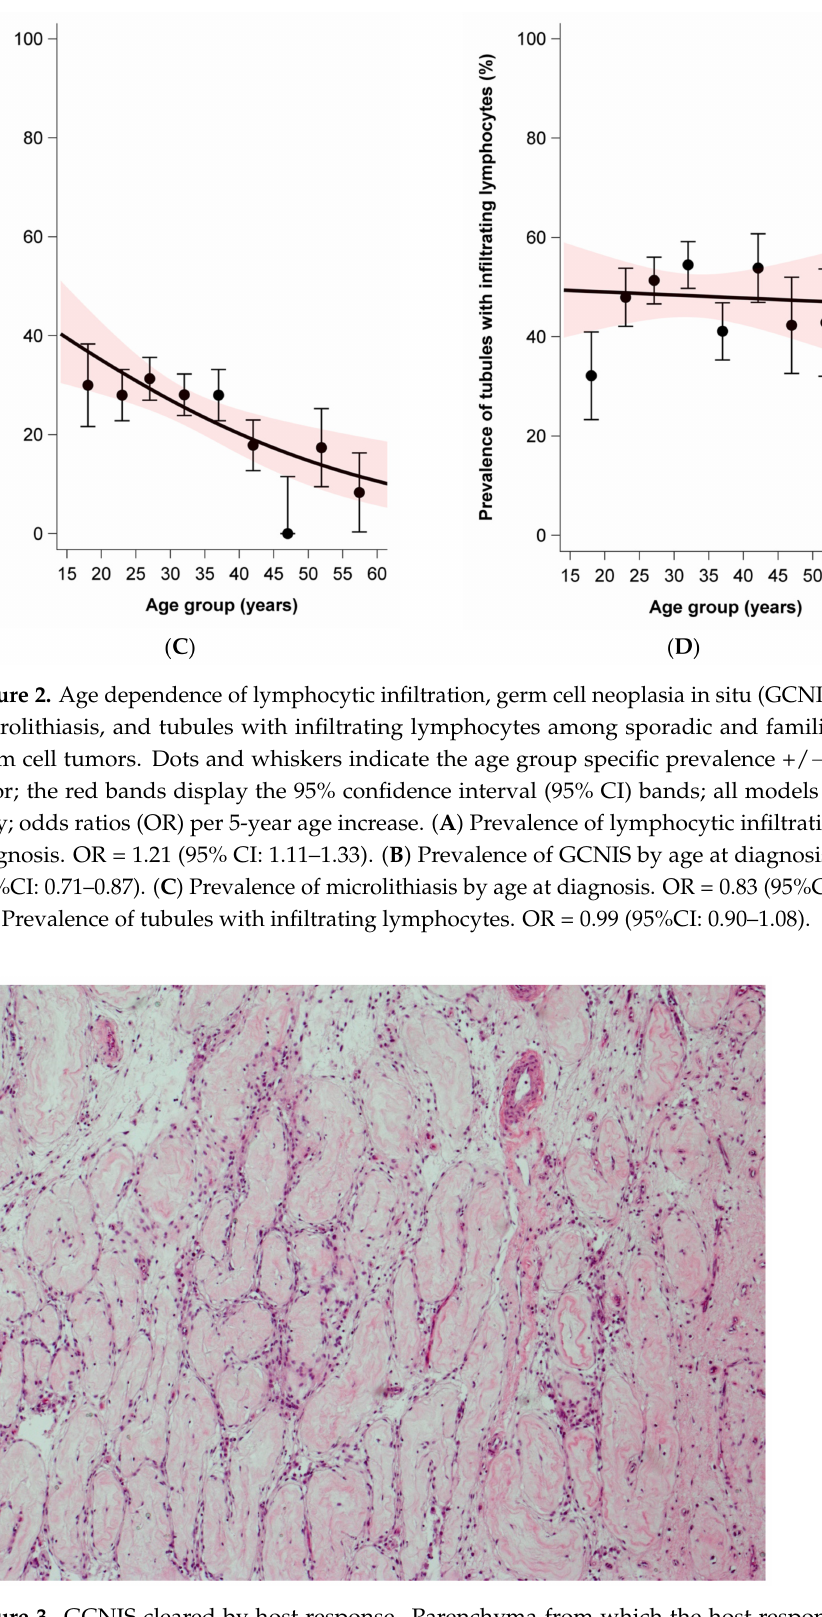
Figure 3. GCNIS cleared by host response. Parenchyma from which the host response has com- pletely cleared GCNIS over time. All tubules have changed into thin fibrotic strands with scattered lymphocytes. (hematoxylin and eosin staining × 50